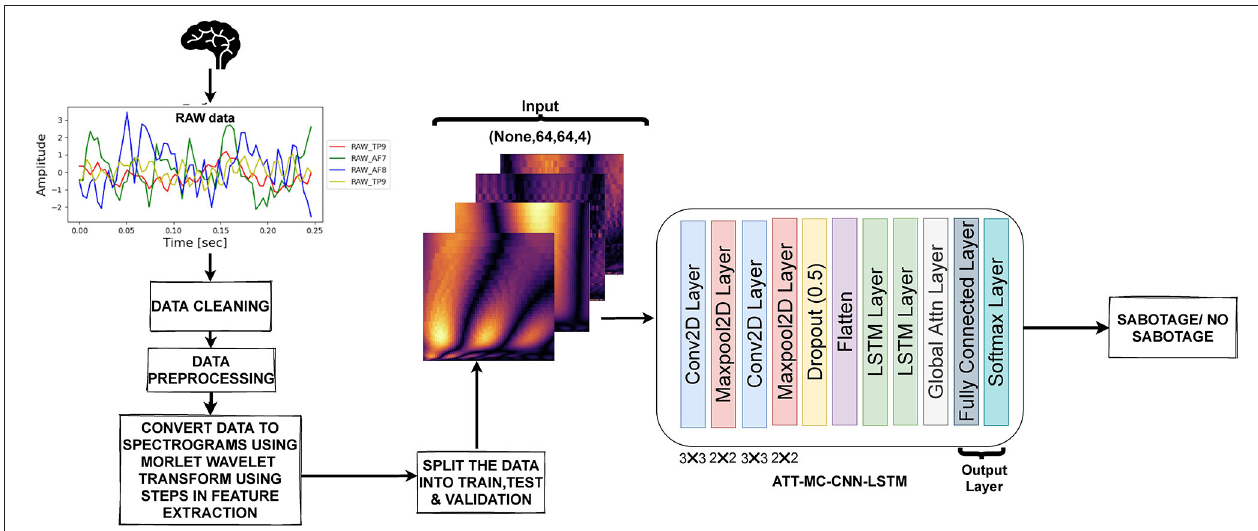
FIGURE 6 | The methodology used in our approach. The raw data obtained were preprocessed, and scalograms were generated from the data. The scalograms from all four channels were sent to the DL model for classification.